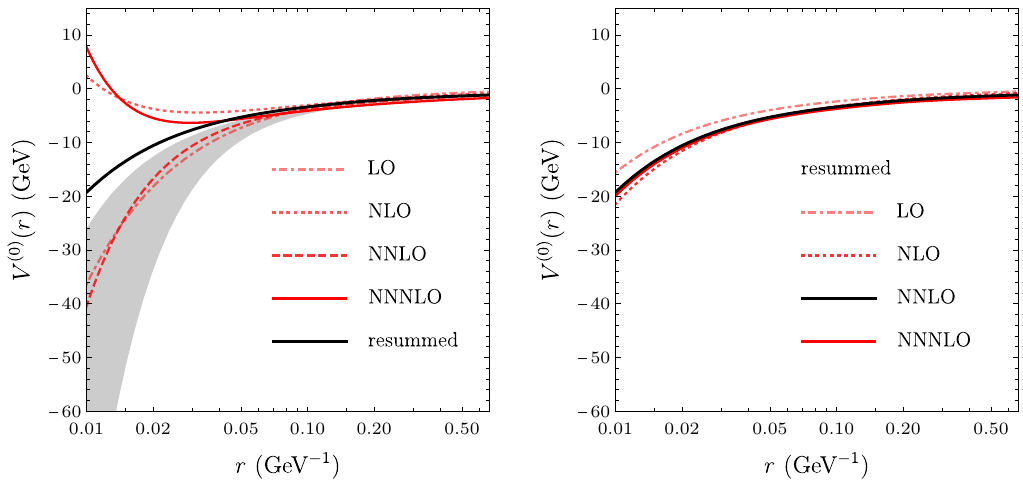
Figure 1 . Left panel: perturbative QCD results for the static potential at a fixed renormalization scale µ R = 2 . 5 GeV with n f = 3 at LO (dot-dashed line), NLO (dotted line), NNLO (dashed line), and NNNLO (red solid line) accuracies, compared with the resummed expression at NNLO accuracy (black solid line) given in eq. (5.10). The gray band shows the effect of varying the fixed renormalization scale µ R between 1 . 5 GeV and 4 GeV on the NNLO expression. Right panel: resummed perturbative QCD results for the static potential at the r -dependent renormalization scale µ r = ( r − 2 + µ 2 ) 1 / 2 with n f = 3 at LO (dot-dashed line), NLO (dotted line), NNLO (black R solid line), and NNNLO (red solid line) accuracies. The position-space expression at NNNLO accuracy has been taken from ref.